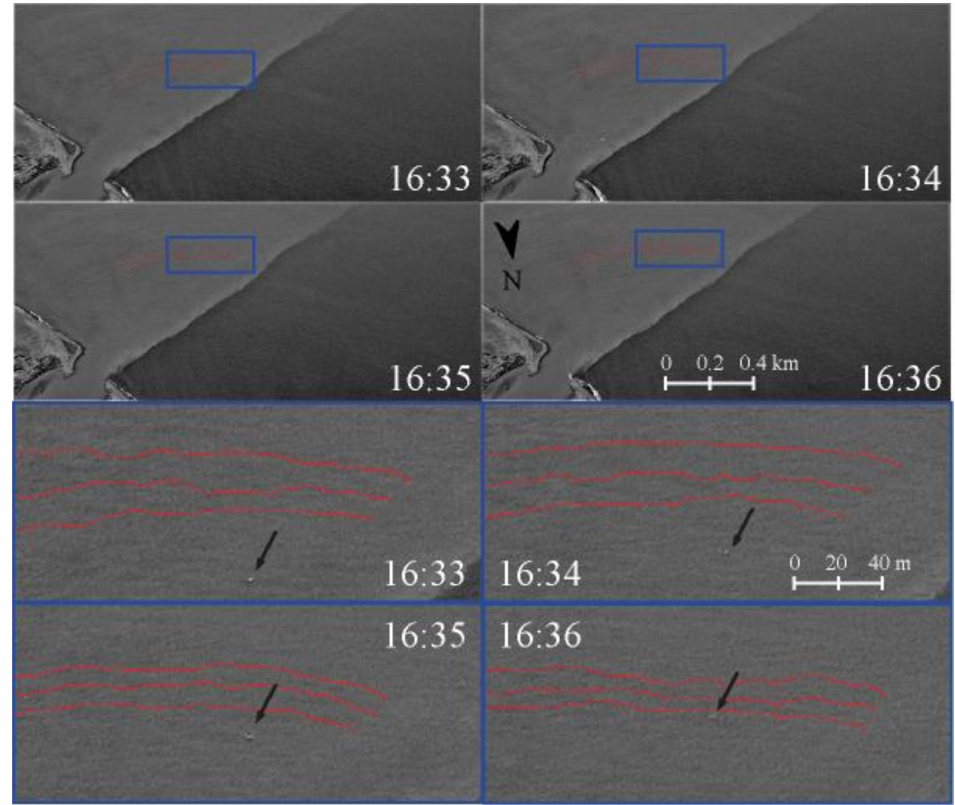
Figure 5. Processed aerial images of the Byzb plume on 16 April at 16:33–16:36 during the second drifting boat experiment. Top images show the near-field part of the Bzyb plume; bottom images show the zoomed-in areas (indicated by the related blue squares in the top images). Red lines indicate ring-like features; black arrows indicate location of the free-drifting boat. Note that the frame of the bottom images is